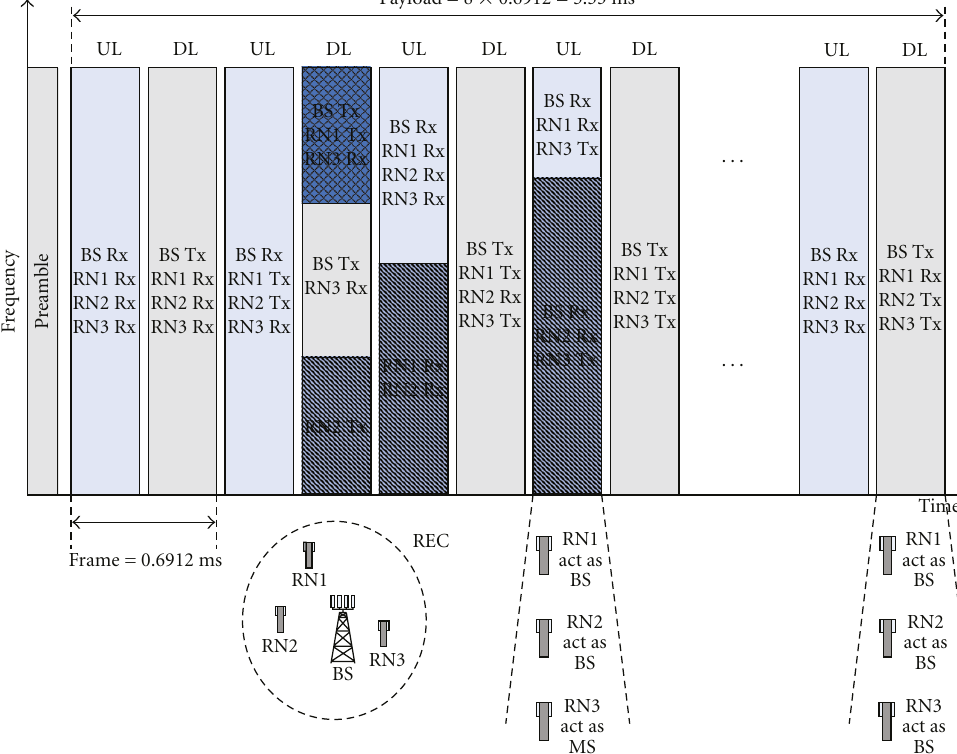
Figure 5: Example allocation of a superframe using the Flexible Resource Assignment scheme in a relay enhanced cell with three relays (RSs). The super-frame consists of a preamble and an 8-frame payload following the WINNER system specifications [36]. The Base Station (BS) allocates (a part of) the resources to the RSs, the RSs independently schedule their associated MS within their allocations when acting as